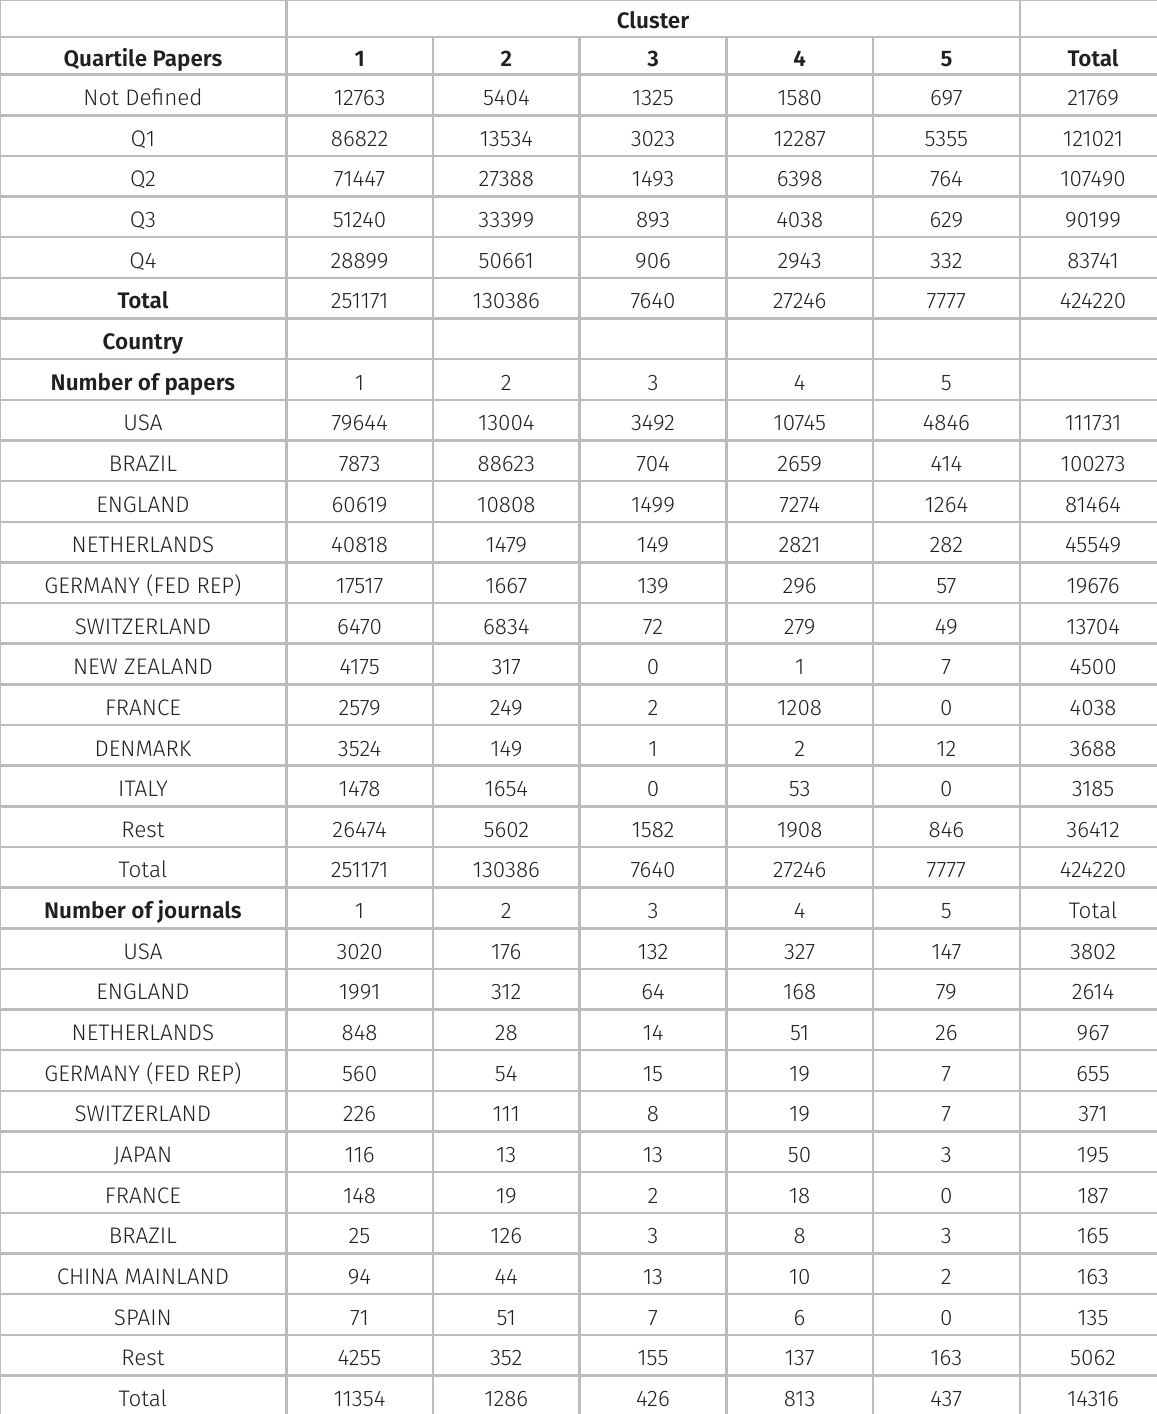
Table IV. Number of papers and journals per cluster, country and quartile from Brazilian authors (InCites ®